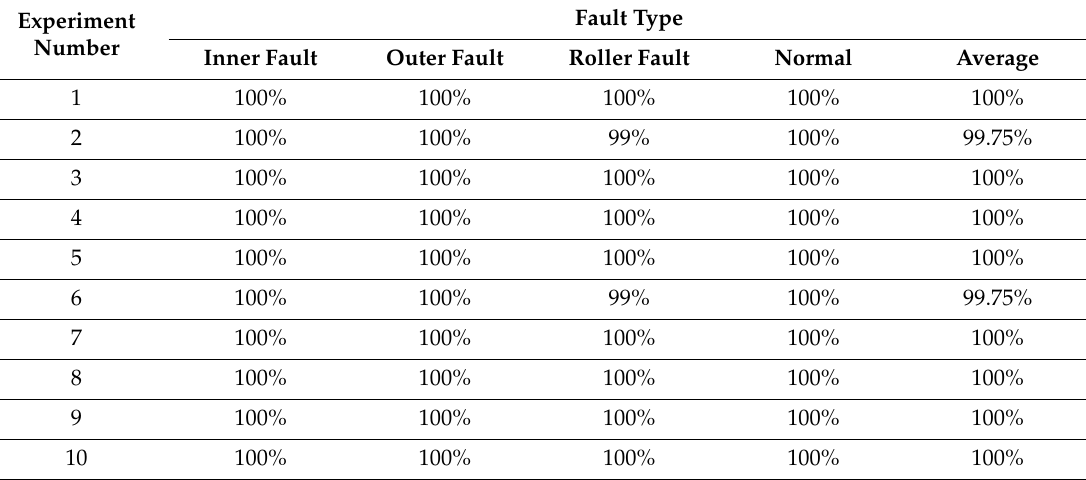
Table 4. Testing results of model 1 in hierarchical fault diagnosis.